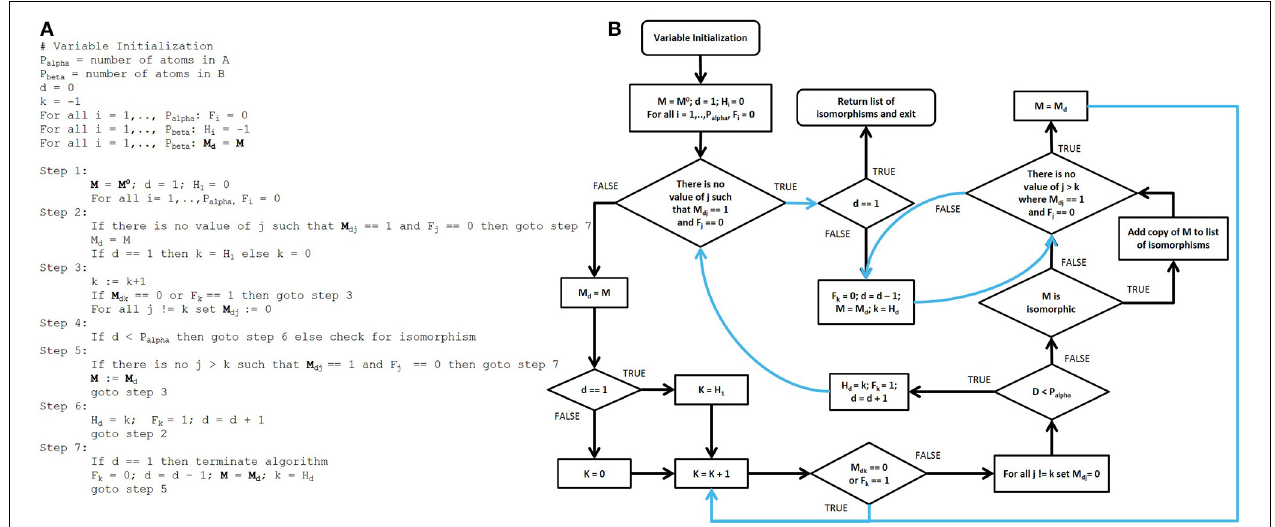
FIGURE 4 | Pseudocode and control flow diagram of the original Ullmann simple enumeration algorithm. (A) The original pseudocode for the Ullmann simple enumeration algorithm. The symbol “: = ” was used in the original algorithm to denote assignment (e.g., d : = d + 1 means “set d equal to d + 1”). (B) Control flow diagram generated from the original published 7-step Ullmann enumeration algorithm pseudocode due to the presence of numerous “goto” statements.